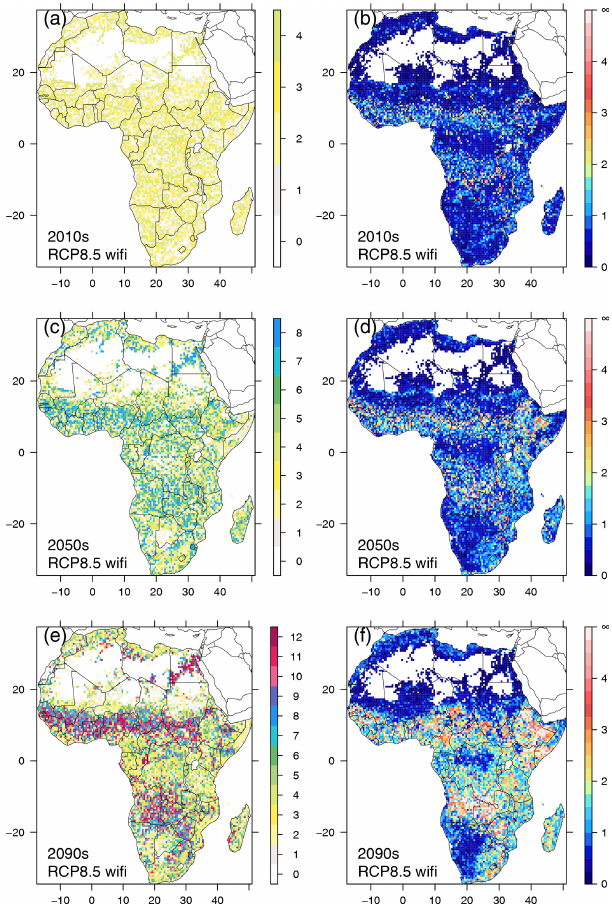
Figure 6. Spatial patterns of lag time (decades) between CDPs for RCP8.5 with fire (a, c, e) and residual Euclidean distance between CDPs (b, d, f) , for three selected decades (2010–2019, 2050–2059, 2090–2099).